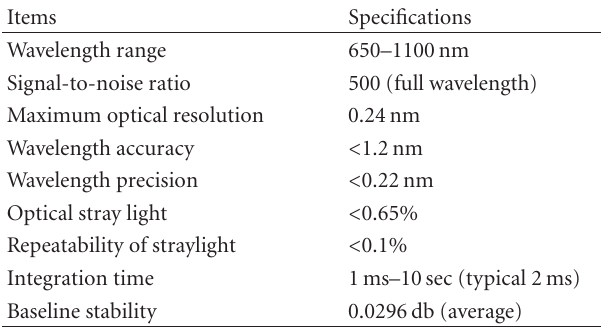
Table 2: The specifications of the developed SW-NIR spectrometer.